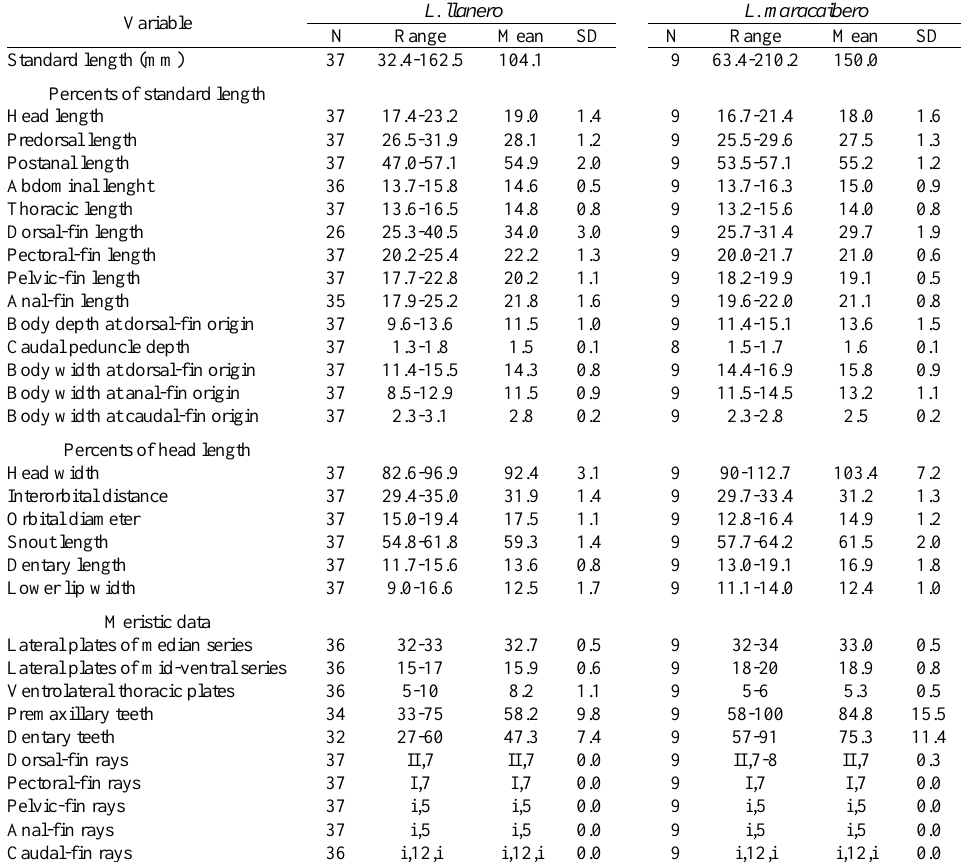
Table 2. Morphometric and meristic data for Lamontichthys llanero and L . maracaibero . SD = standard